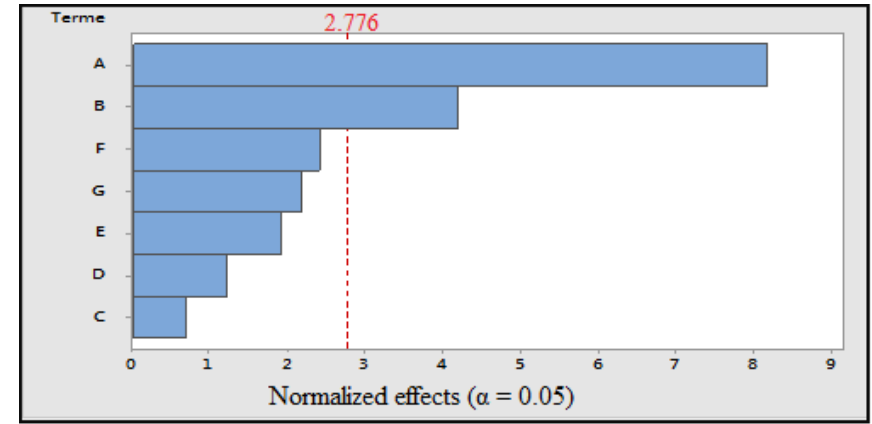
Figure 4. Pareto diagram of normalized effects (α = 0.05); A: cooking time; B: power; C: volume of cooking water; D: concentration of solvent; E: maceration time; F: ultrasonic time; and G: grinding.